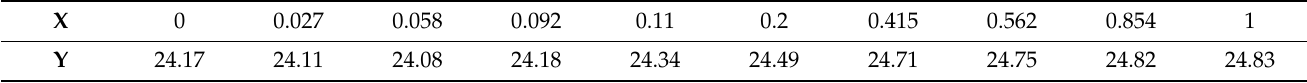
Table 2. Coordinates of sampling points.